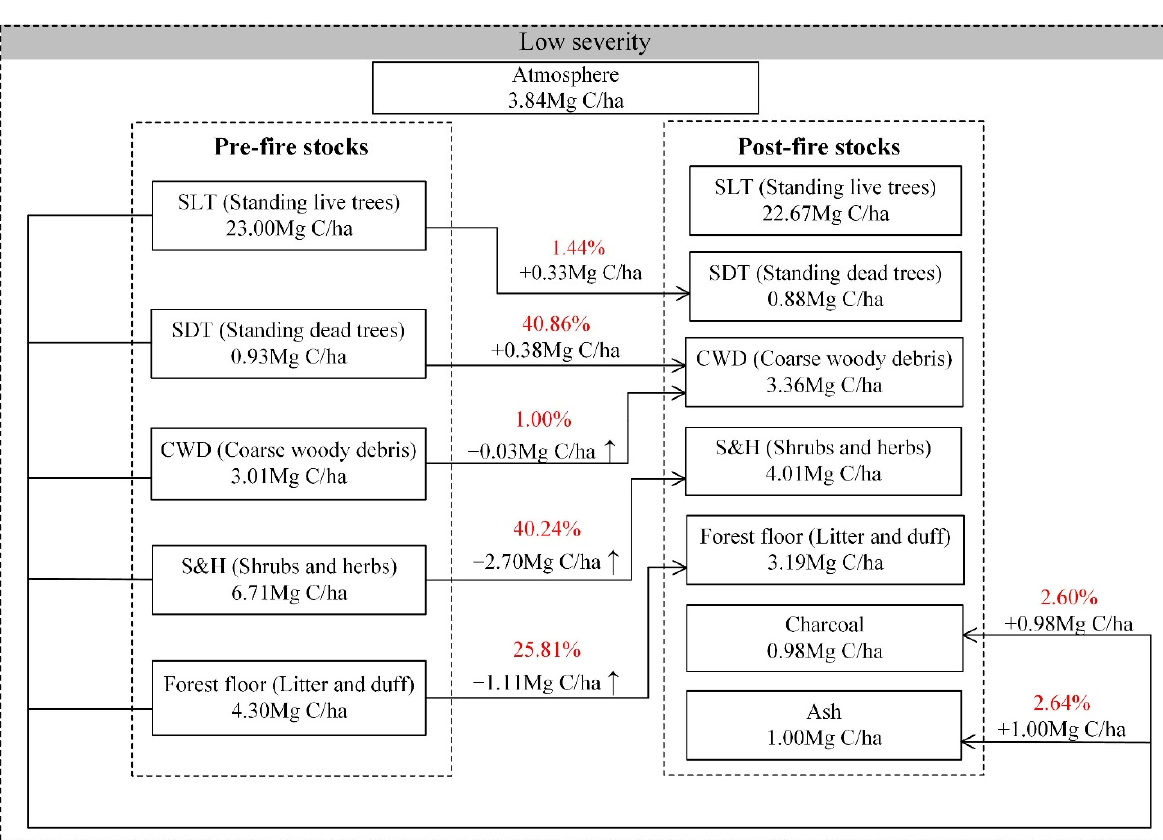
Figure 5. Carbon emissions, transfers, and ratios of changes for each aboveground carbon pool under low-severity fires.